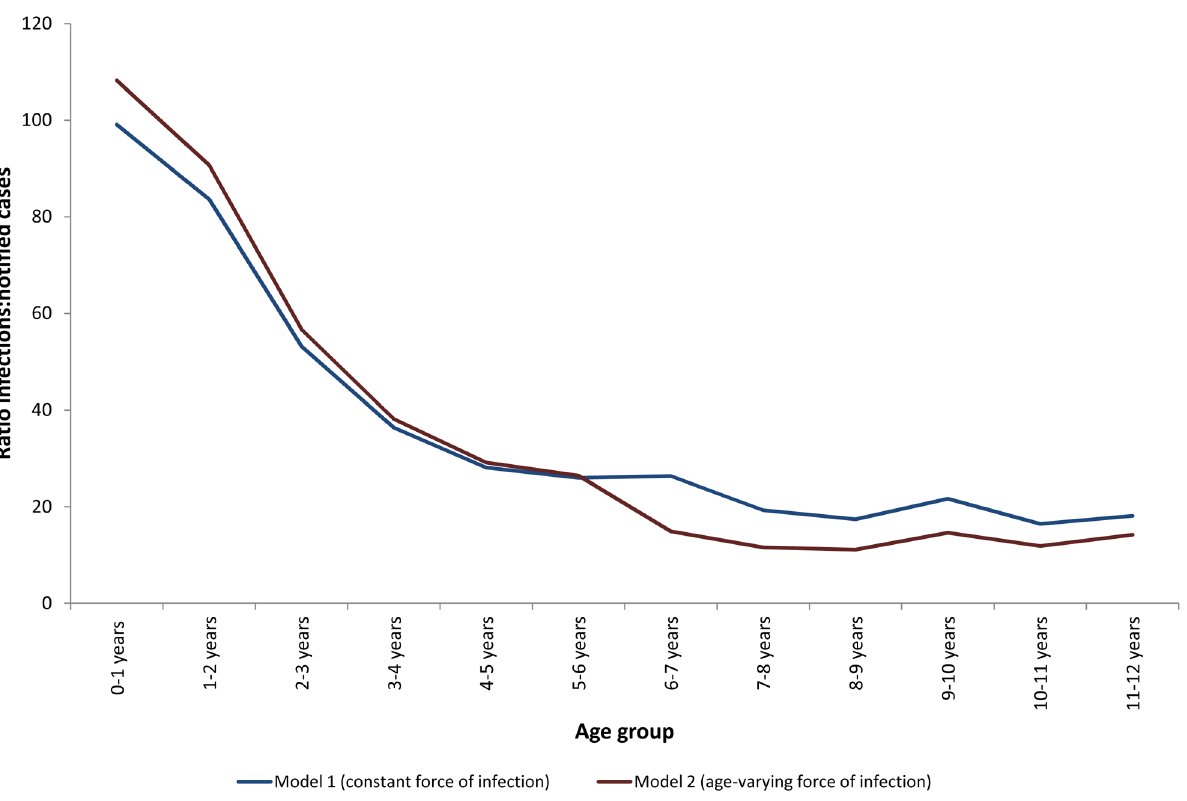
Figure 3. Ratio of dengue infections to notified cases by age in Colombo Municipal Council, 2009. Blue line: Model 1 (constant force of infection); Red line: Model 2 (different forces of infection above and below 6 years).